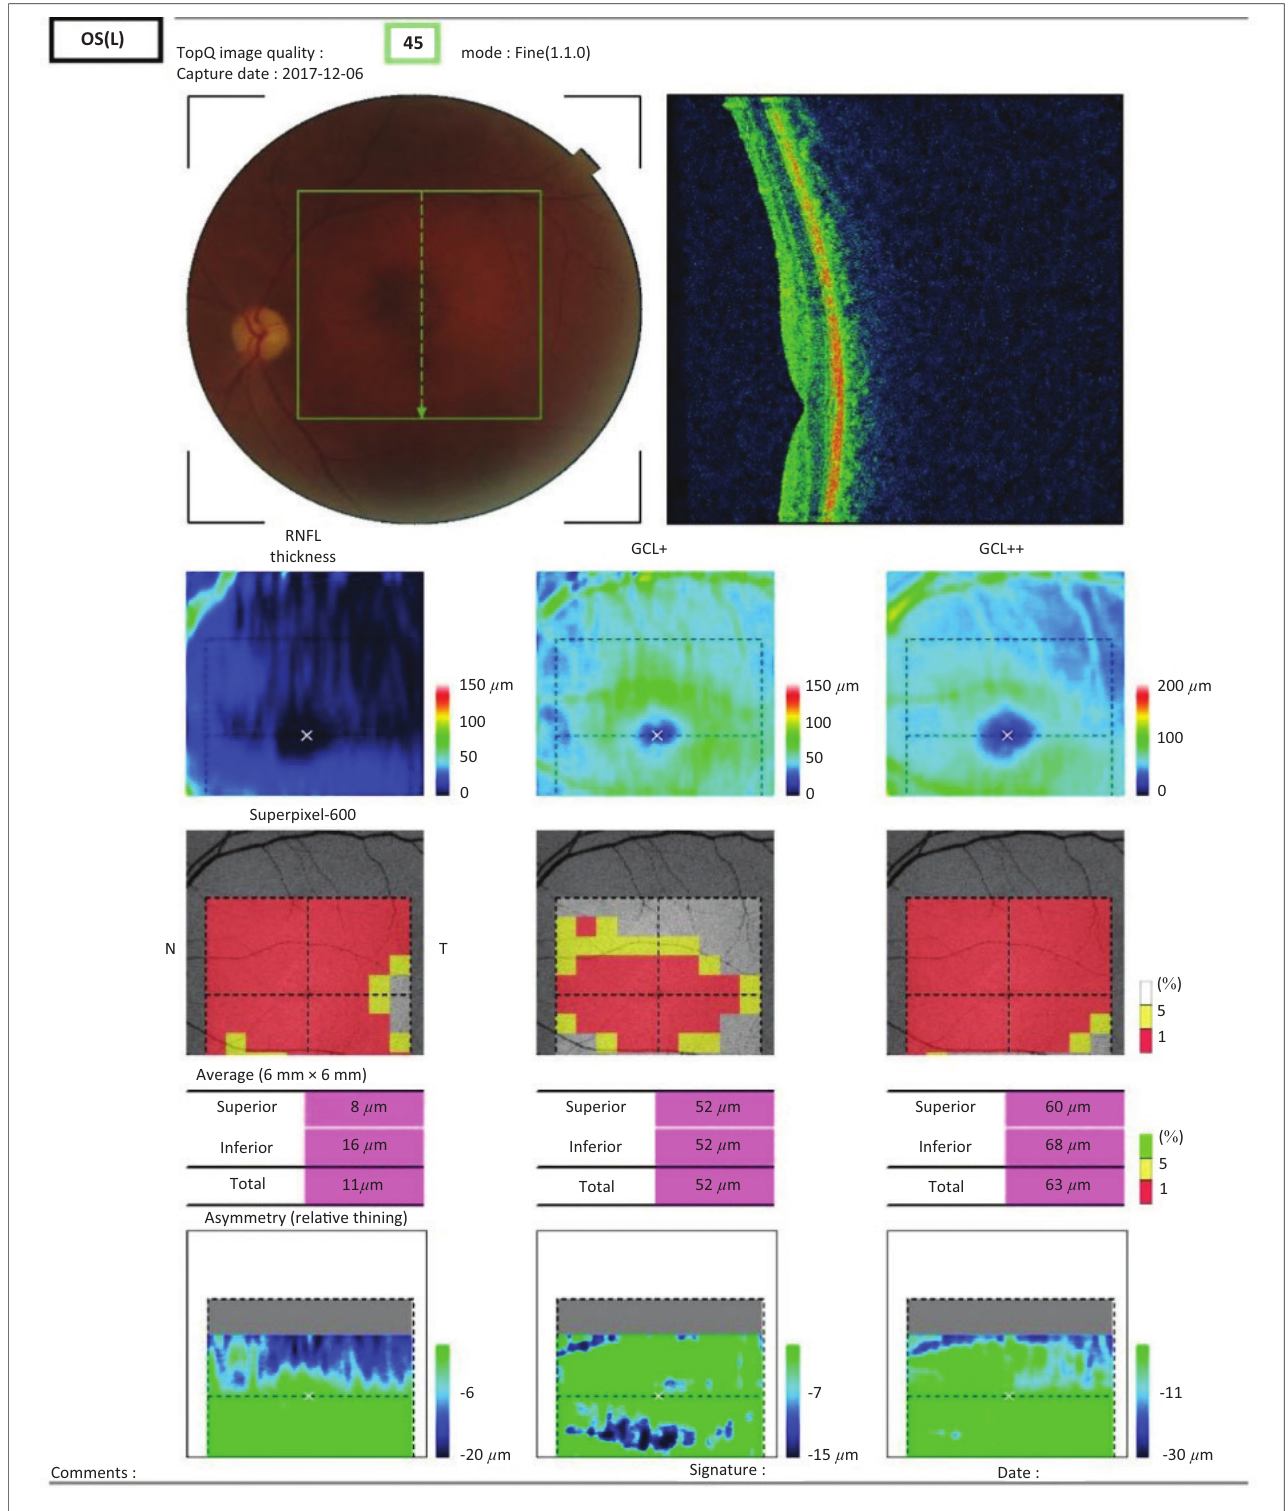
FIGURE 3: Topcon optical coherence tomography scan for the left eye showing the presence of left eye optic atrophy. The retinal nerve fibre layer and ganglion cell layer are both thinner than expected, suggesting possible retinal nerve fibre layer